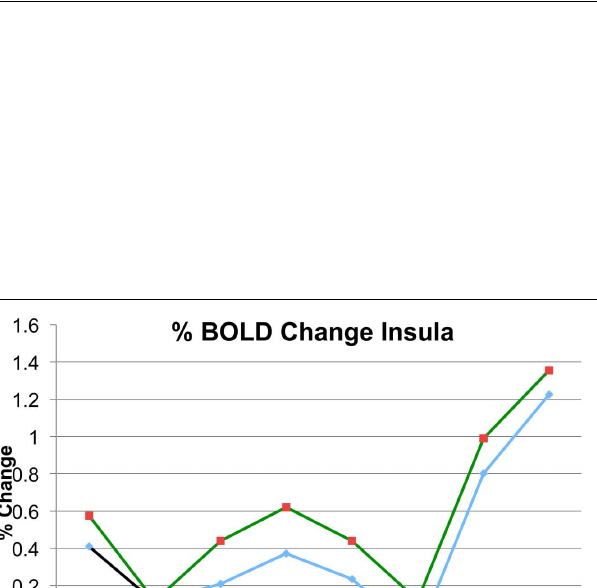
FIGUREA5 |Time series of percentage BOLD change for G(15,3).